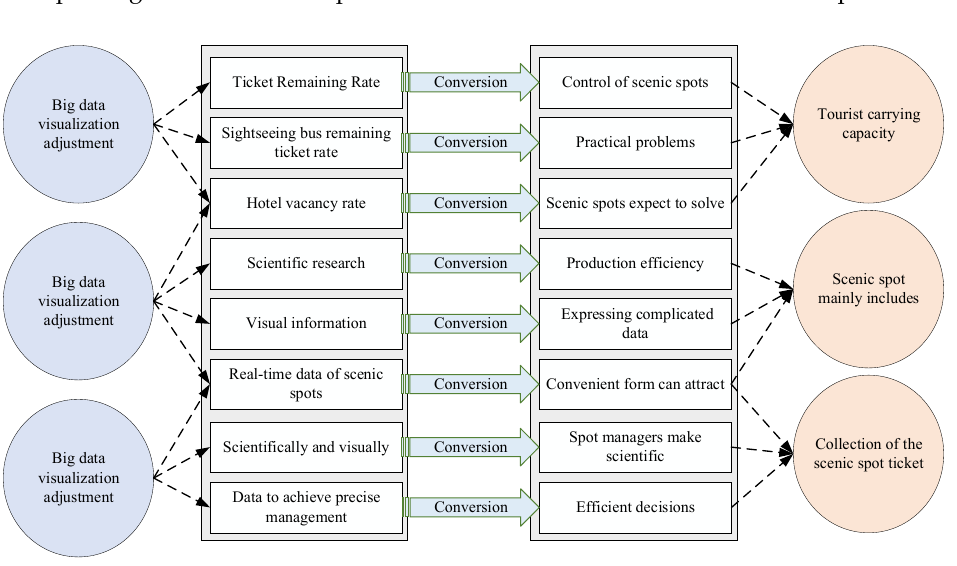
Figure 2. Adjustment of big data visualization.